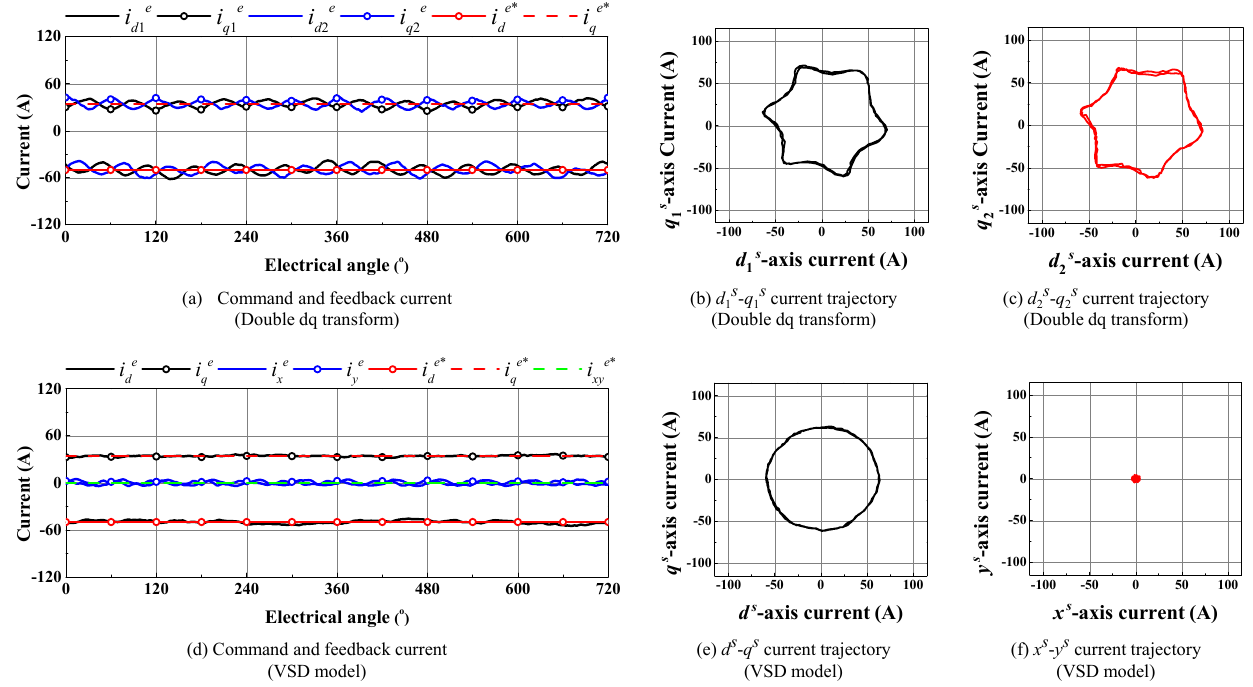
Figure 8. Experiment results of rotational coordinate command, feedback currents ( a , d ), and stational coordinate current trajectory ( b , c , e , f ) when applying to the Double dq transform and VSD model.